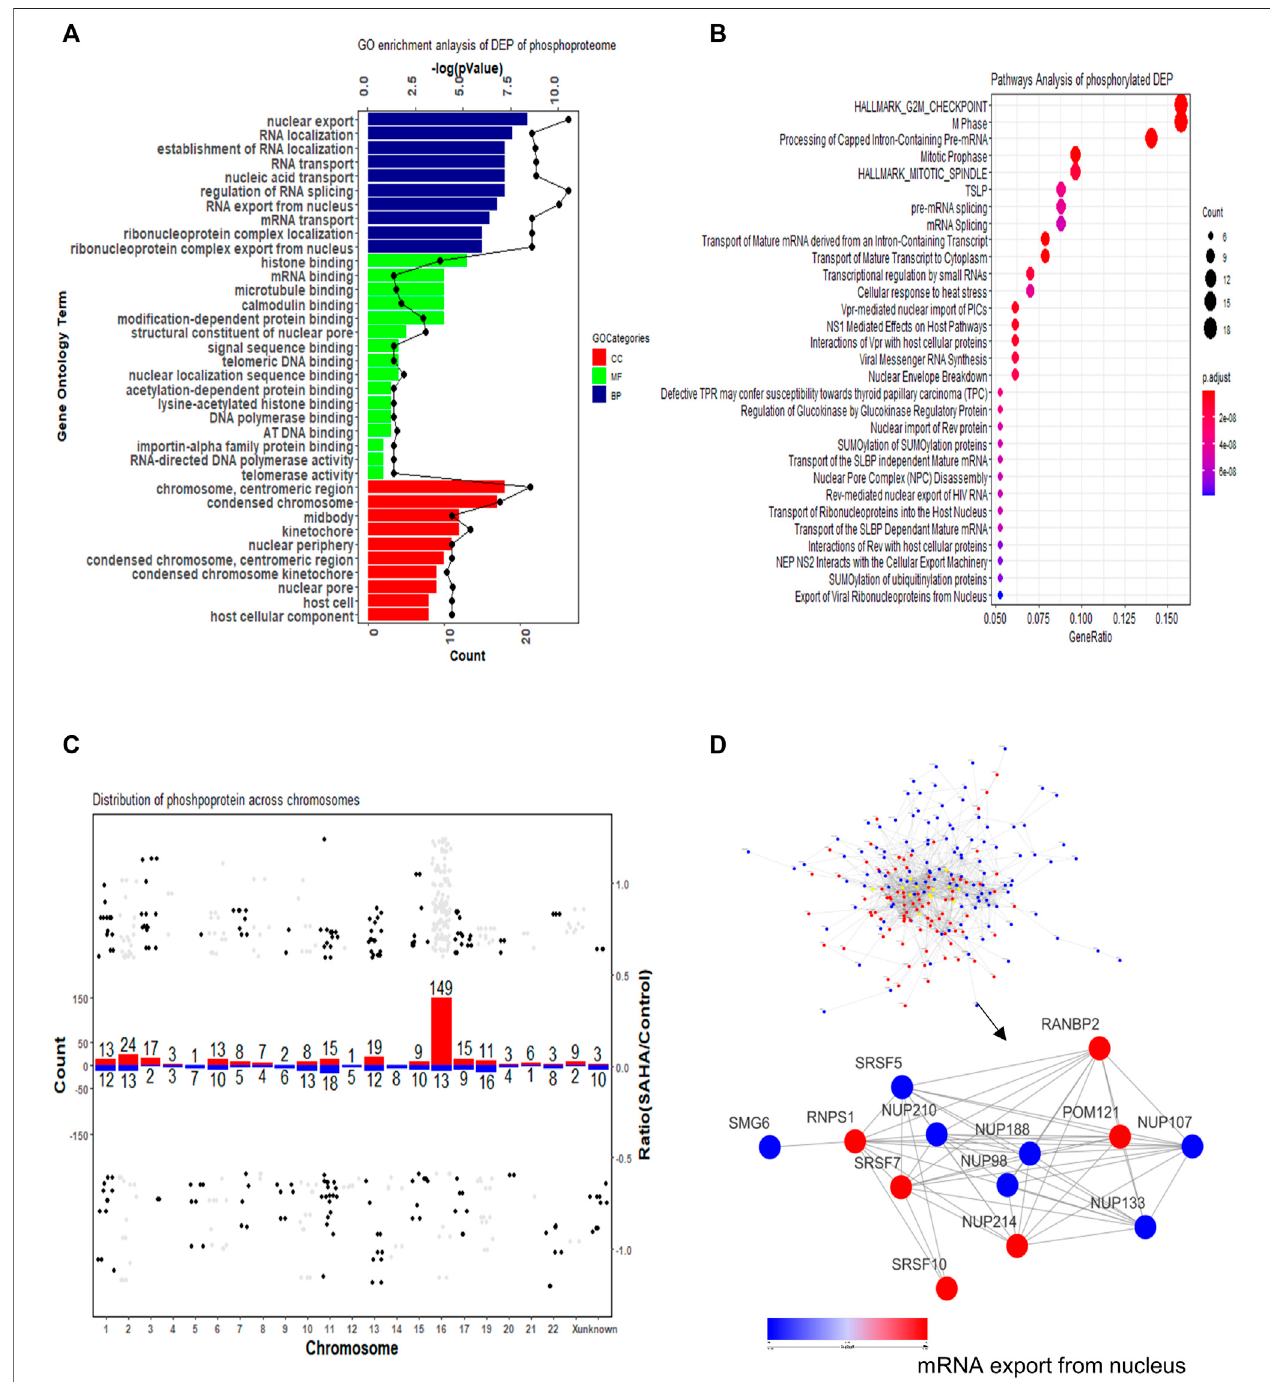
FIGURE5| Functionalenrichmentclusteranalysisofquanti fi edphosphorylatedproteins. (A) GOenrichmentanalysis. (B) KEGGpathwayanalysis. (C) Distribution ofphosphorylatedproteinsacrosschromosomes.Thenumberaboveeachbarindicatedthetotalnumberofphosphorylatedproteinsineachchromosome.Theredbar refers to upregulated proteins; the blue bar refers to downregulated proteins. (D) Protein – protein interaction network of phosphoproteome. Both global network and representative mRNA export processes are displayed.